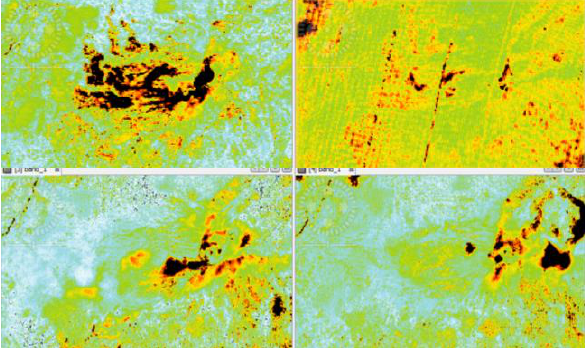
Figure 5. RX spectral anomalies obtained from images in 07/04/2013 (left up ALI), 05/09/2013 (right up